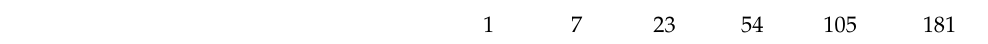
1 7 23 54 105 181 32.7 7.5 6.3 4.3 0.7 2.5 − − − − − − 40.1 10.9 8.0 5.3 1.4 3.0 − − − − − − 22.7 0.5 0.8 0.0 2.7 0.2 − − 36.6 17.6 18.6 18.0 15.7 17.8 − − − − − − 22.7 0.5 0.8 0.0 2.7 0.2 − − −